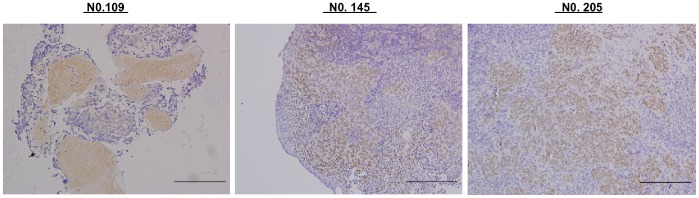
Immunohistochemical stainings of EBV LMP-1 in the NPC tumor tissues from 3 representative cases (scale bar = 200 µm).The LMP-1 immunohistological scores were 220, 200 and 100 for specimen No. 109, 145 and 205, respectively.